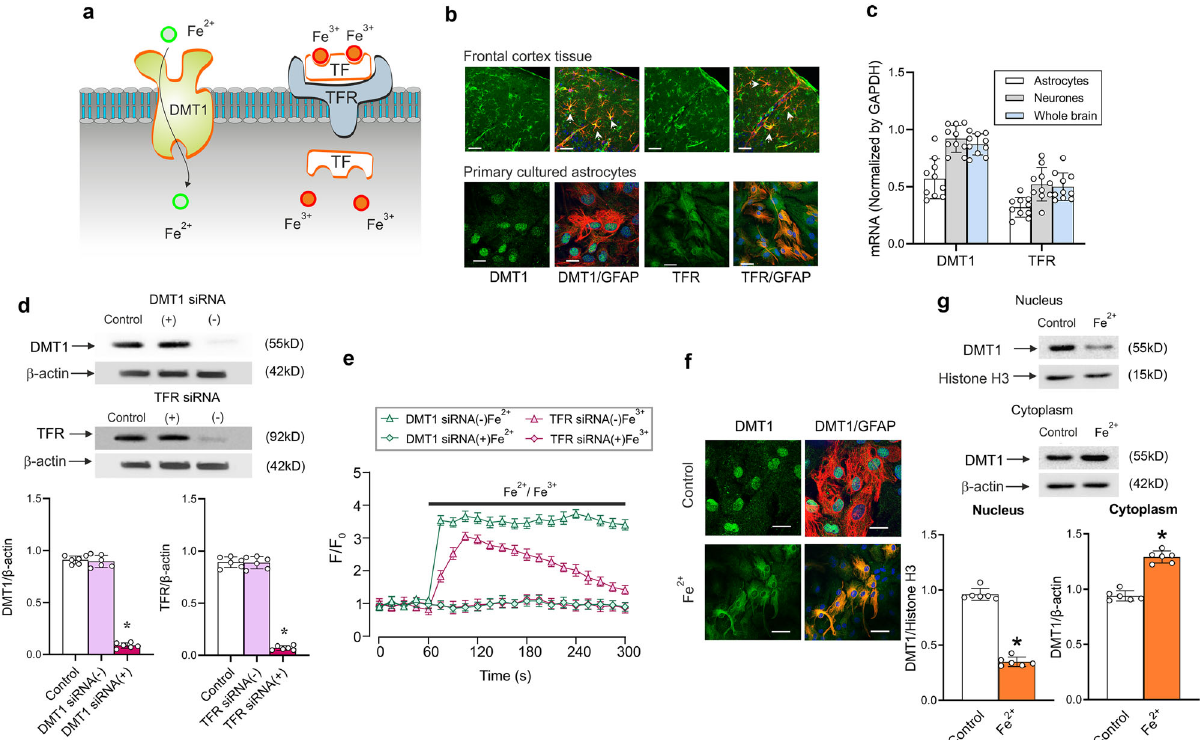
Fig. 2 Astrocytic expression of DMT1 and TFR. a Astrocytes accumulate Fe 2 + through plasmalemmal divalent metal transporter 1 (DMT1/SLC11A2) whereas Fe 3 + is taken up by internalisation of Fe 3 + -TF-TFR complex. b Images of astrocytes in the somato-sensory cortex preparations or in primary culture double-immunolabeled with antibodies against DMT1 or TFR and against GFAP. Scale bar, 20 μ m. c The mRNA expression of DMT1 and TFR measured by qPCR in astrocytes sorted from GFAP-GFP mice, in neurones sorted from Thy1-YFP mice, and in whole cerebral tissue of wild type mice. d Representative western blot bands for DMT1 and TFR in cultured astrocytes treated with sham (Control), siRNA negative control ( − ) or positive duplex chains ( + ). The protein levels are shown as the ratio of DMT1 (55 kDa) and β -actin (42 kDa), and TFR (92 kDa) and β -actin. Data represent mean ± SD, n = 6. *Indicates statistically signi fi cant ( p < 0.05) difference from the value of baseline in the same group. e [Ca 2 + ] 2 + or Fe 3 + i transients evoked by Fe after RNA interference and down-regulation of protein synthesis. After treatment with DMT1 or TFR siRNA negative control ( − ) or positive duplex chains ( + ) for 3 days, [Ca 2 + ] i dynamics i n response to Fe 2 + /Fe 3 + was monitored. Every data point represents mean ± SD, n = 10. f Images of astrocytes in primary culture treated with sham (Control) or Fe 2 + for 5 min and double-immunolabelled with antibodies against DMT1 and against GFAP. Scale bar, 25 μ m. g Redistribution of DMT1 induced by Fe 2 + in the extracted proteins of nucleus and cytoplasm. Every data point represents mean ± SD, n = 10. *Indicates statistically signi fi cant ( p < 0.05) difference from control